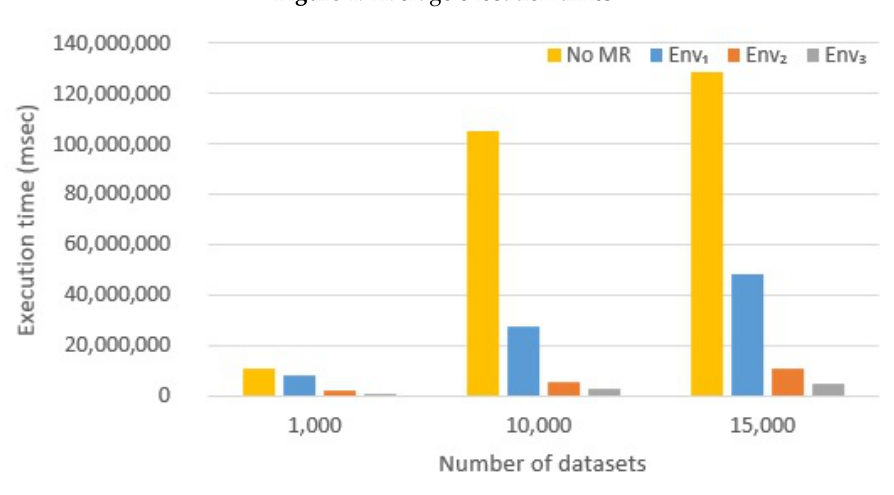
Figure 4. Average execution times.